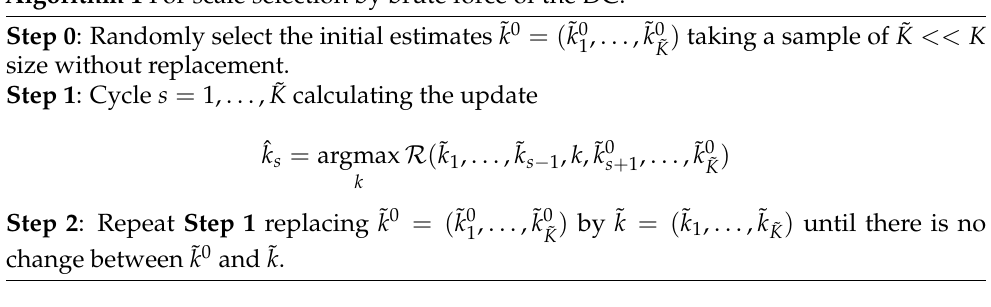
Algorithm 1 For scale selection by brute force of the DC.